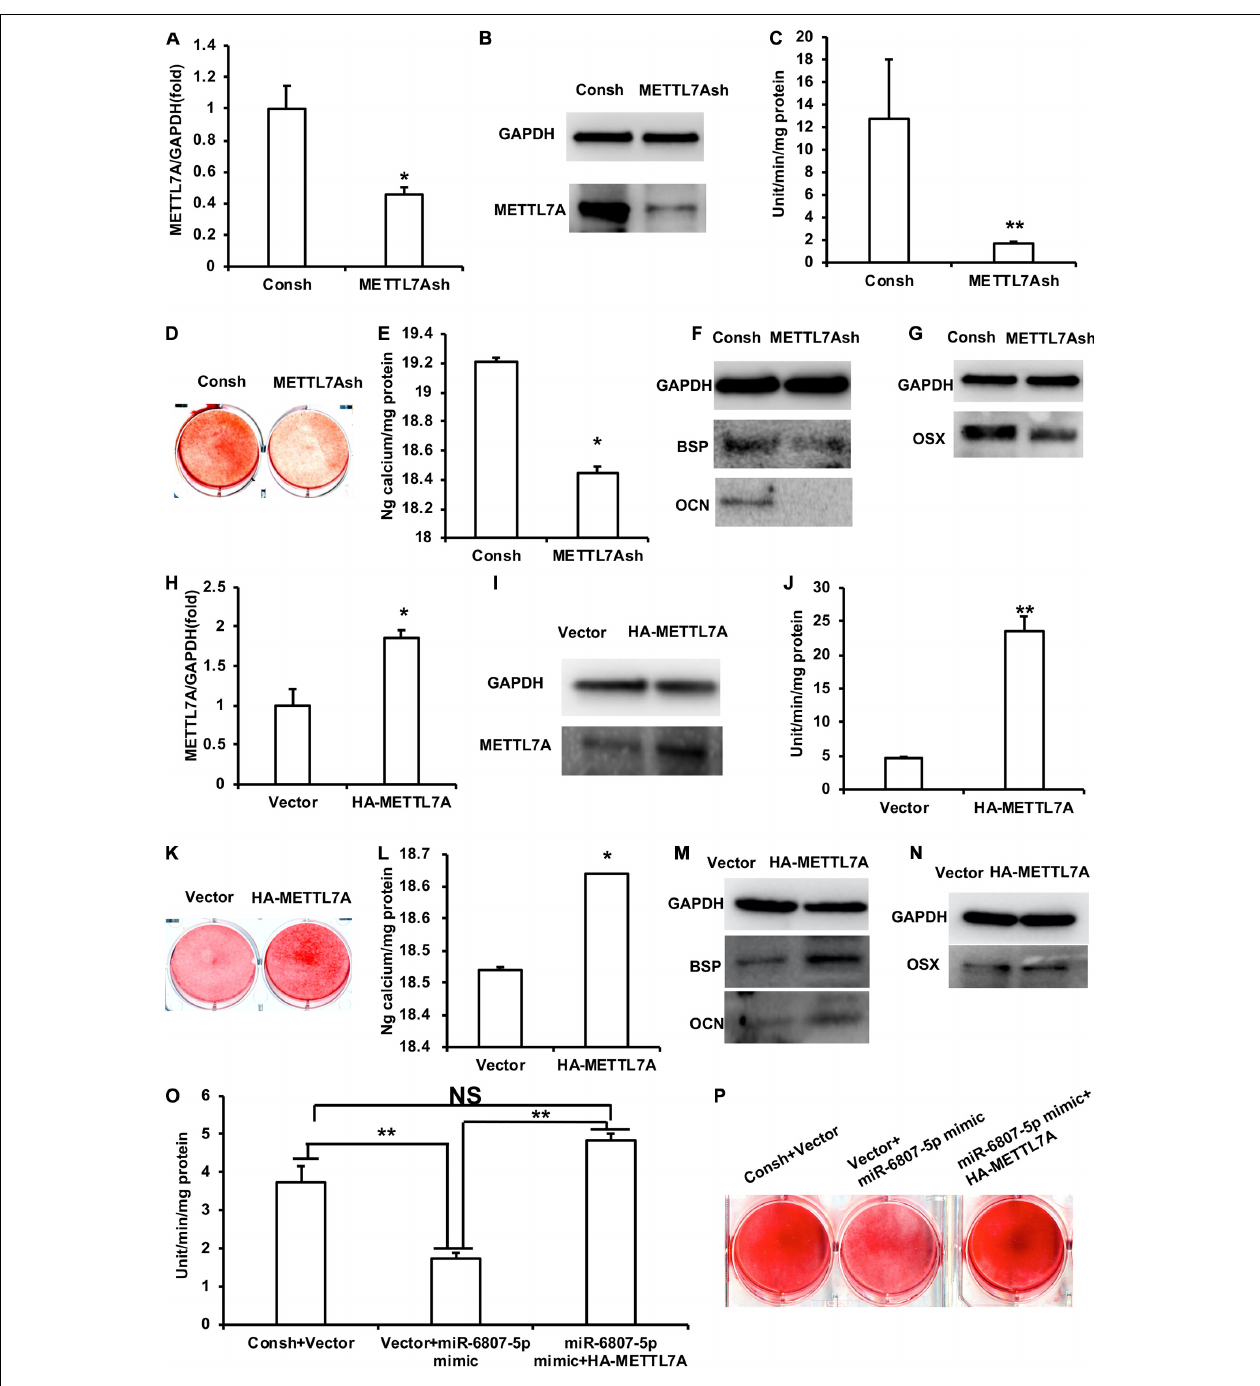
FIGURE 4 | METTL7A promoted the odontogenic differentiation of DPSCs. (A,B) The expression of METTL7A was detected by real-time RT-PCR and western blot. (C) ALP activity after 5 days of mineralized induction. (D,E) ARS and calcium ion quantification after 2 weeks of induction. (F) The expressions of BSP and OCN were detected by western blot after 1 week of induction. (G) The expression of OSX was weakened in the METTL7Ash group compared with that in the control group detected by western blot. (H,I) The expression of METTL7A was detected by real-time RT-PCR and western blot. (J) ALP activity after 5 days of mineralized induction. (K,L) ARS and calcium ion quantification after 2 weeks of mineralized induction. (M) The expressions of BSP and OCN were detected by western blot after 1 week of induction. (N) The expression of OSX was detected by western blot. (O) ALP activity of the Consh + Vector, Vector + miR-6807-5p mimic, and miR-6807-5p mimic + HA-METTL7A groups after 5 days of mineralized induction. (P) ARS of the Consh + Vector, Vector + miR-6807-5p mimic, and miR-6807-5p mimic + HA-METTL7A groups after 2 weeks of mineralized induction. GAPDH was used as internal control. Student’s t -test or Tukey’s post hoc tests used after one-way ANOVA was performed to determine statistical significance. All error bars represent the standard deviation ( n = 3). * p ≤ 0.05, ** p ≤ 0.01.